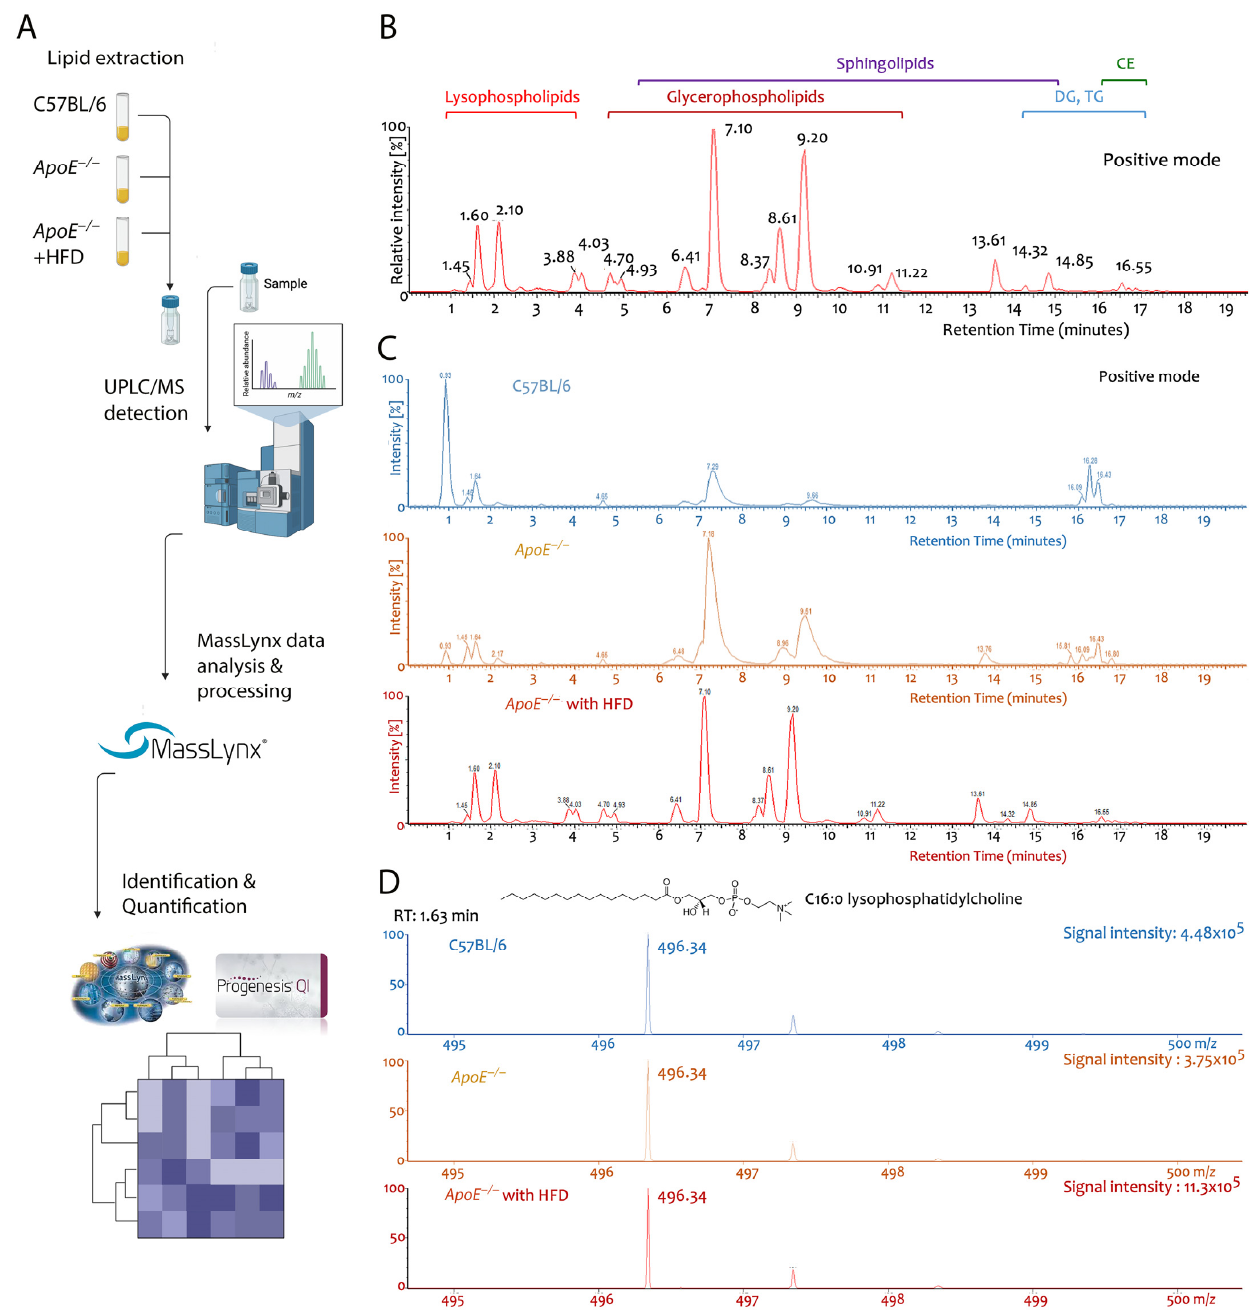
Figure 1. Lipidomic profiling of mouse plasma using UPLC/MS E . ( A ) Total lipids were extracted from the plasma from the respective groups (n = 7, each). MarkerLynx and Progenesis QI software were used to analyze and quantify the MS data. Heatmaps were used generated to display the results. ( B ) Using a CSH™ C18 column, total lipids were separated into lysophospholipids, glycerophospho- lipids, sphingolipids, CEs, and glycerolipids (DG, TG). The results were acquired in the positive mode. ( C ) The representative lipidomic profiling in plasma from the respective groups are demonstrated based on retention time and signal intensity. ( D ) Pattern of parent and daughter ion of LPC from the respective groups with their signal intensities. Abbreviations: apoE − / − : apolipoprotein E knockout; HFD: high-fat diet; UPLC: ultra-performance liquid chromatography; MS E : data-independent collec- tion mode mass spectrometry; MS: mass spectrometry; CSH: charged surface hybrid; CE: cholesteryl ester; DG: diacylglycerol; TG: